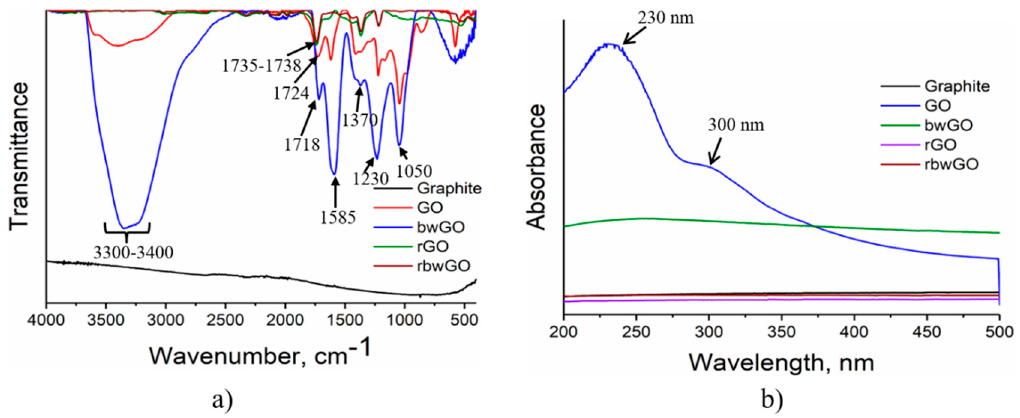
Figure 3. FTIR ( a ) and UV-Vis ( b ) spectra of GO, base-washed GO and their reduced